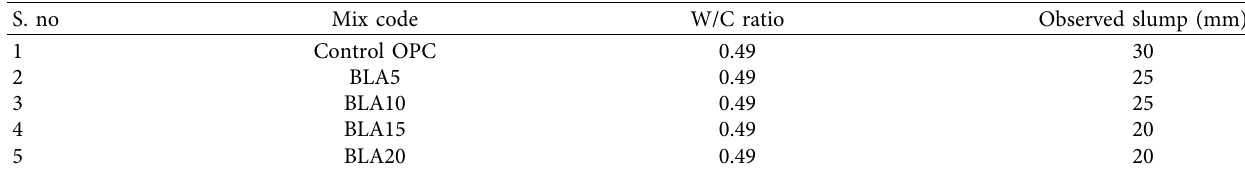
Table 8: Slump value.